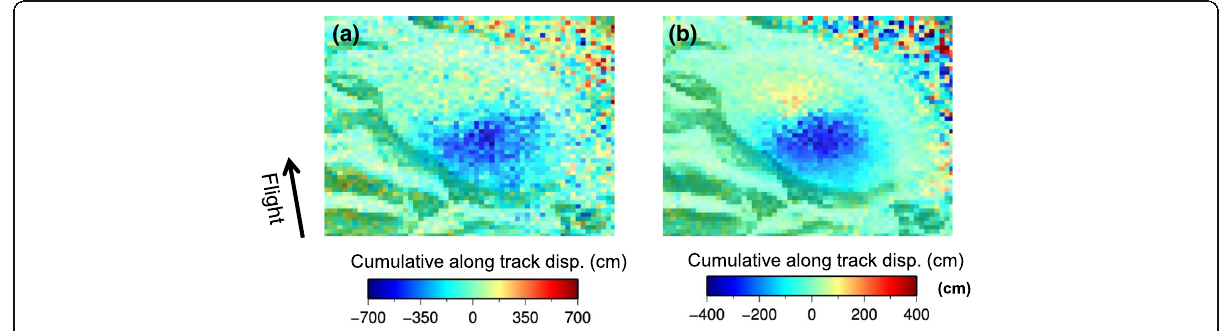
Fig. 9 Cumulative observed MAI data derived from a ALOS/PALSAR data (P36 – 43), and b ALOS-2/PALSAR-2 ascending data (P44 –